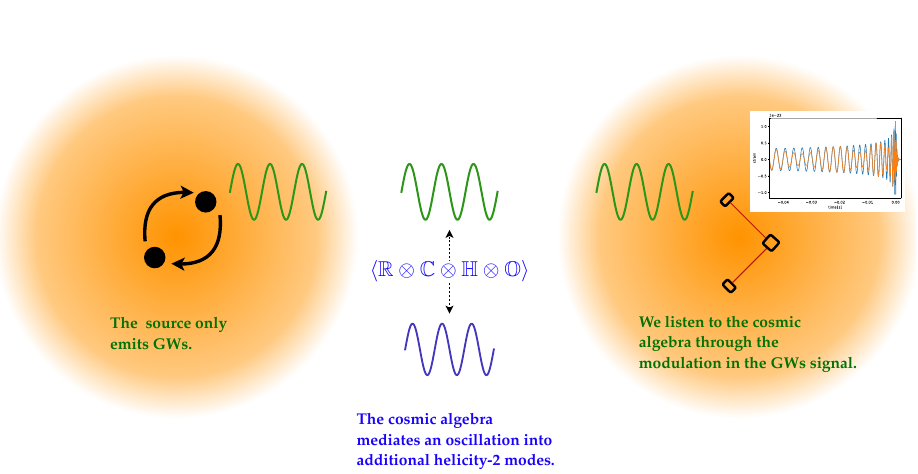
Figure 2. This figure illustrates the considered scenario leading to the oscillation of GWs. Initially, a pure GWs signal is generated by the source. The cosmic medium with a non-trivial background of R C H O induces an oscillation between GWs. Our interferometers will only be sensitive to the ⊗ ⊗ ⊗ GWs signal, but the oscillations are imprinted so we can indirectly hear the sounds of the